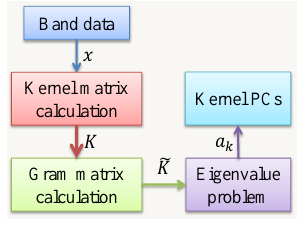
Figure 6. Flowchart for Kernel